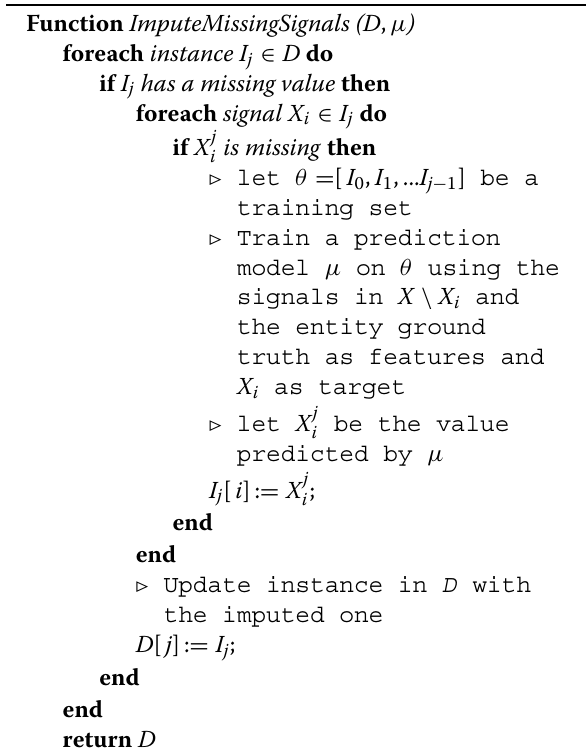
Algorithm 1: Imputing missing signal values with a prediction model μ using a data set D that includes a list of instances ( I ) where each instance I is a list storing the values of signals in X and the entity ground